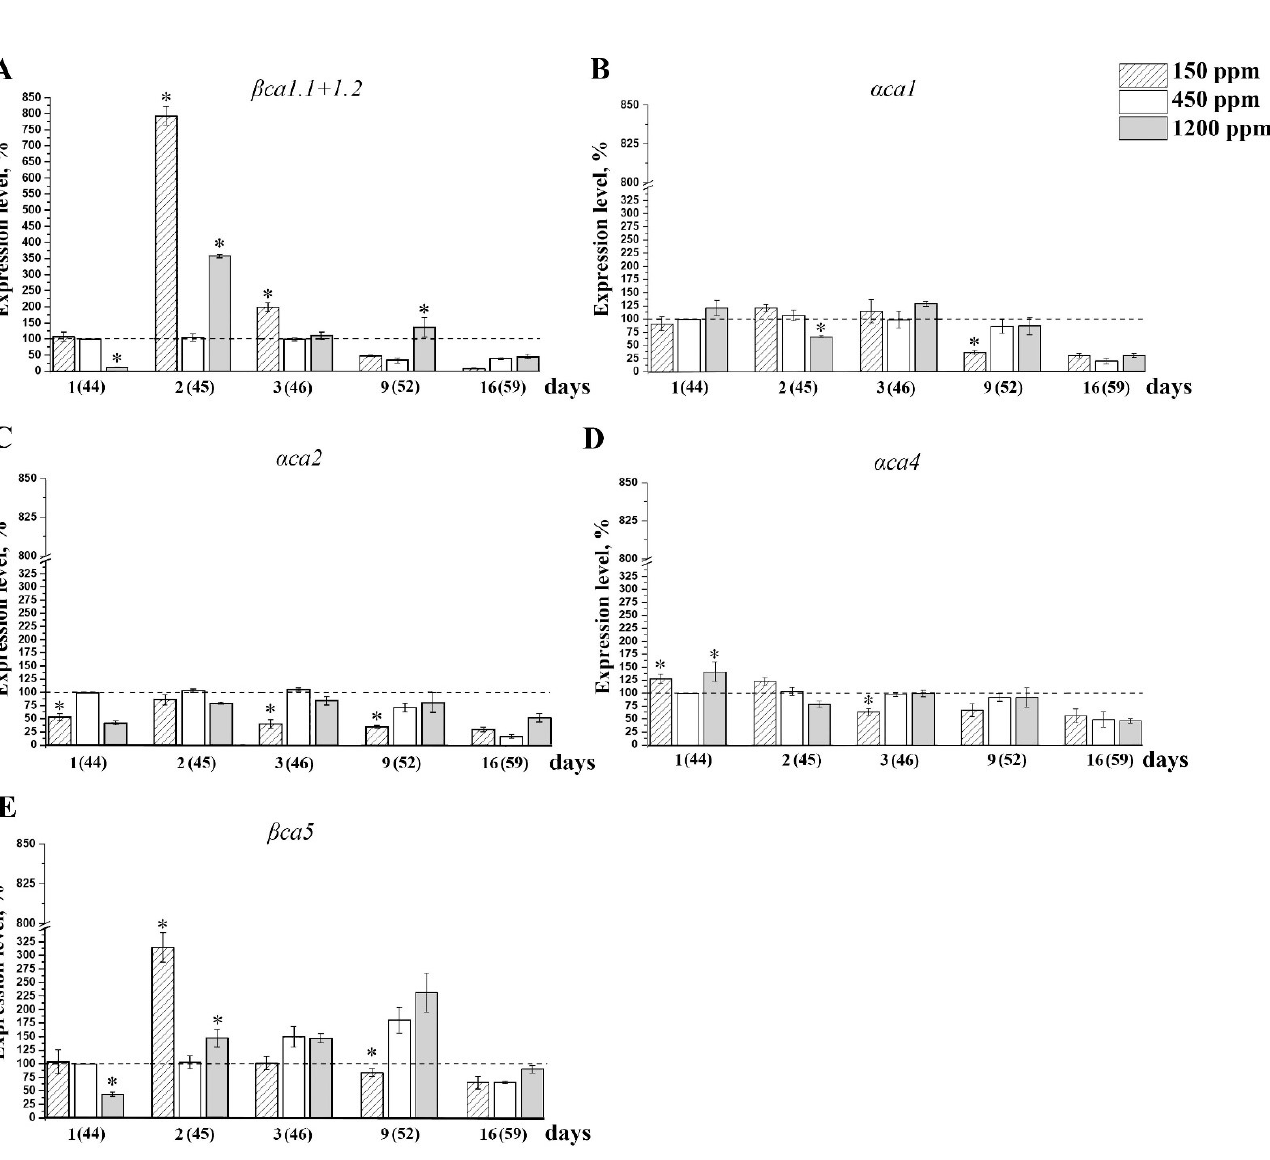
Figure 6. Levels of expression of genes encoding chloroplast carbonic anhydrases in Arabidopsis plant leaves after introduction to low (150 ppm), and high (1200 ppm) CO 2 levels in the air. Numbers on the X -axis show the number of days after moving the plants of 43 days of age grown at 450 ppm at the atmospheric CO 2 level to conditions of changed CO 2 level in the air. The 100% value (dashed horizontal line) is the expression level of the corresponding genes encoding CAs in the plants of 44 days of age grown at 450 ppm (Table 2). Data are shown as mean ± the SE. The experiments were performed three times with similar results. ( A )— βca1.1 + 1.2 ; ( B )— αca1 ; ( C )— αca2 ; ( D )— αca4 ; ( E )— βca5 . Asterisks denote statistically significant differences between values for different CO 2 levels on the same experimental day, p < 0.01.